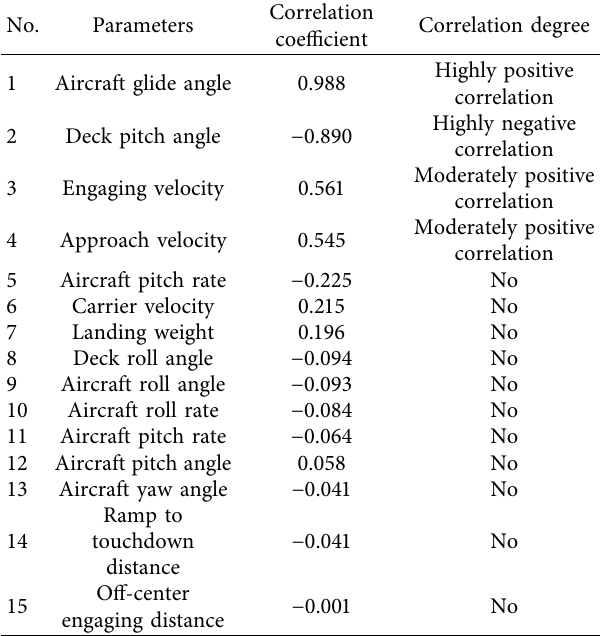
Table 1: Partial correlation analysis results between deck landing parameters and sinking velocity of